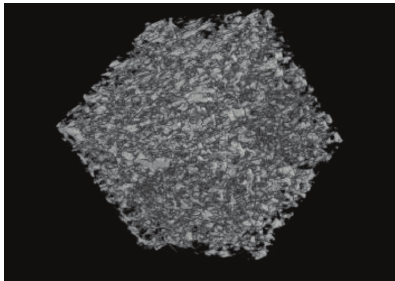
Fig. 5. An example of three-dimensional visualization of pore space of rock model (claystone) in the new computer